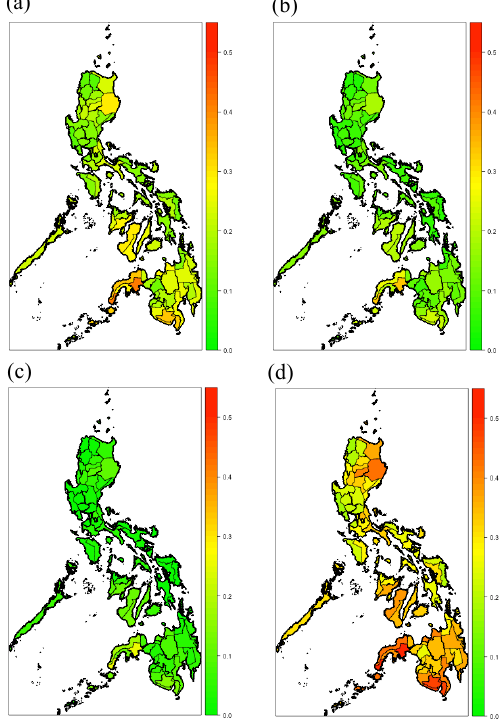
Figure 4. Drought probabilities for (a) near-normal, (b) moderate, (c) severe and (d) all kinds of drought